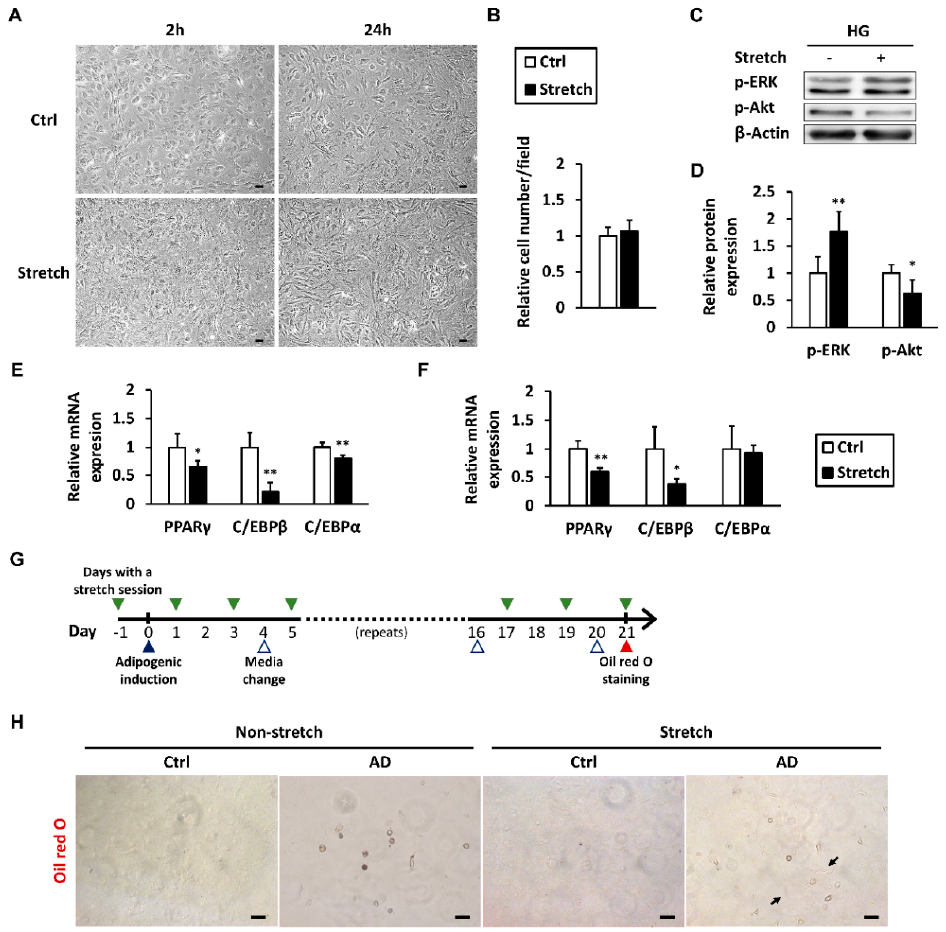
Figure 5. Mechanical stretch modulates ERK and Akt signaling and represses adipogenic differentiation. Tenocytes in high-glucose conditions were subjected to a 2-h mechanical stretch session. ( A ) Cell morphology was observed using a light microscope 2 and 24 h after the session began, scale bar = 50 µ m; ( B ) Cell number was counted in three random visual fields from each of the three culture wells at the 24-h time point; 6 h after the stretch began, p-ERK and p-Akt in tenocytes were ( C ) immunoblotted and ( D ) quantified ( n = 4); The mRNA expression of adipogenic markers was analyzed at ( E ) 2- and ( F ) 6-h time points; Data are presented as the mean ± SD ( n = 4). Statistical significance is shown as * p <0.05 or ** p <0.01 compared to the non-stretched control group; ( G ) Timeline of the adipogenic differentiation protocol for tenocytes with regular exposure to mechanical stretch; ( H ) Adipogenesis was examined using Oil Red O staining on the 21st day of induction. Arrows indicate the stretched tenocytes retained their spindle shape. AD: adipogenic differentiation medium. Ctrl: culture medium. Scale bar = 50 μ m.